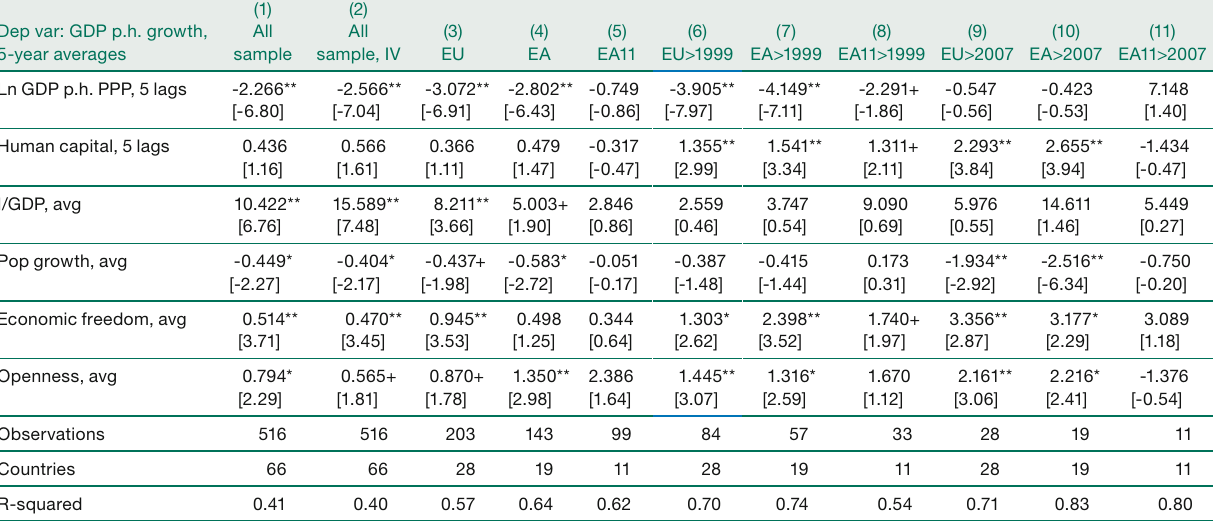
Conditional beta convergence: Output per